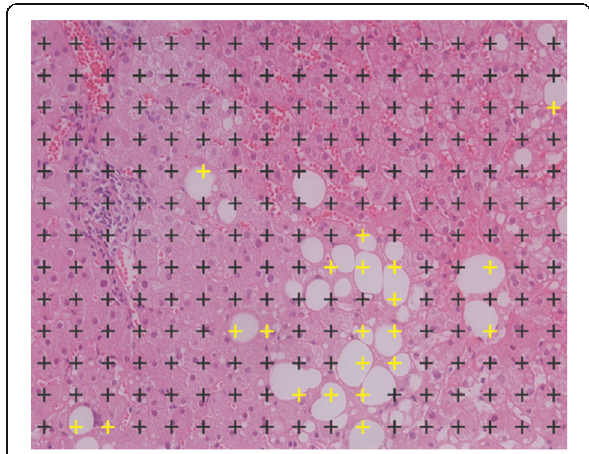
Fig. 2 Stereological point counting. A region of interest is overlaid by a regular grid of points that are counted as fat (yellow) or no-fat